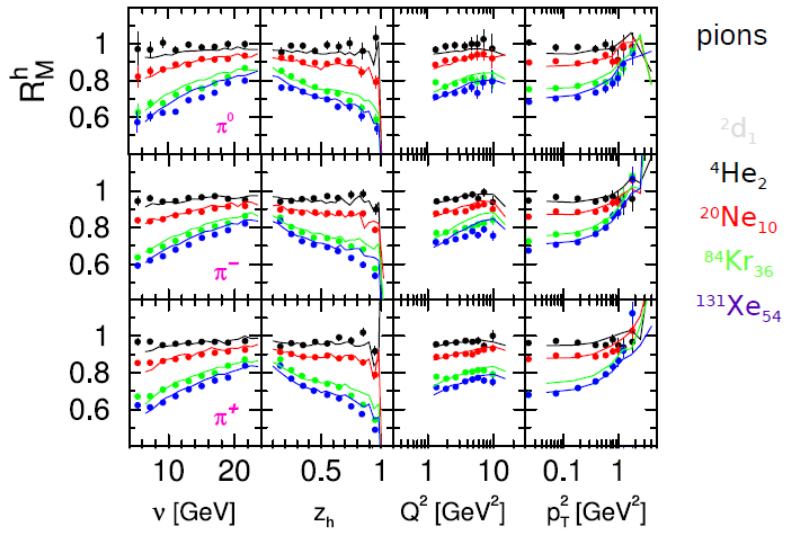
Figure 3. Nuclear modification factor for pions as a function of energy transfer, ν , relative final hadron energy, z h = E h / ν , momentum transfer squared, Q 2 , and the produced hadron tranverse momentum squared, p 2 . The various targets are as indicated. Data are from the HERMES experiment T